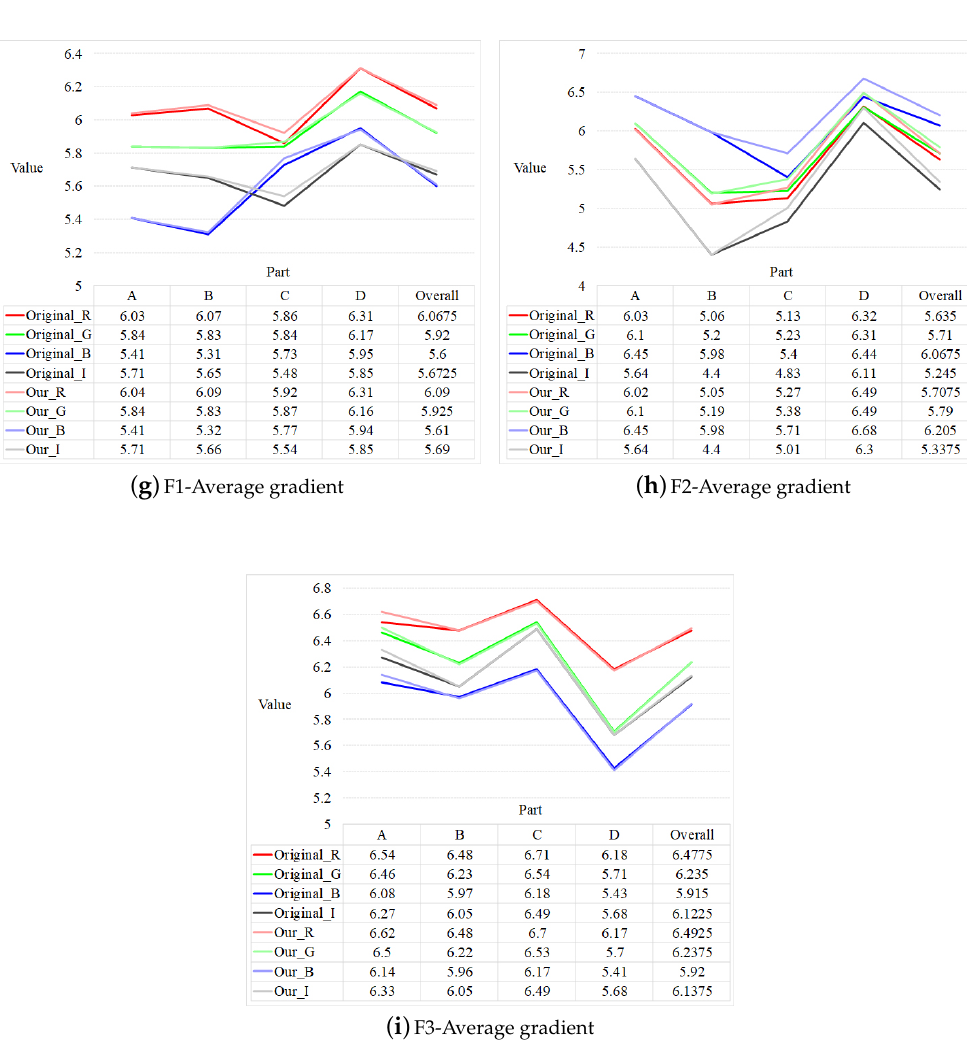
Figure 11. Statistics of the original images and the results after processing. The mean, standard deviation, and average gradient of F1, F2, and F3 are shown